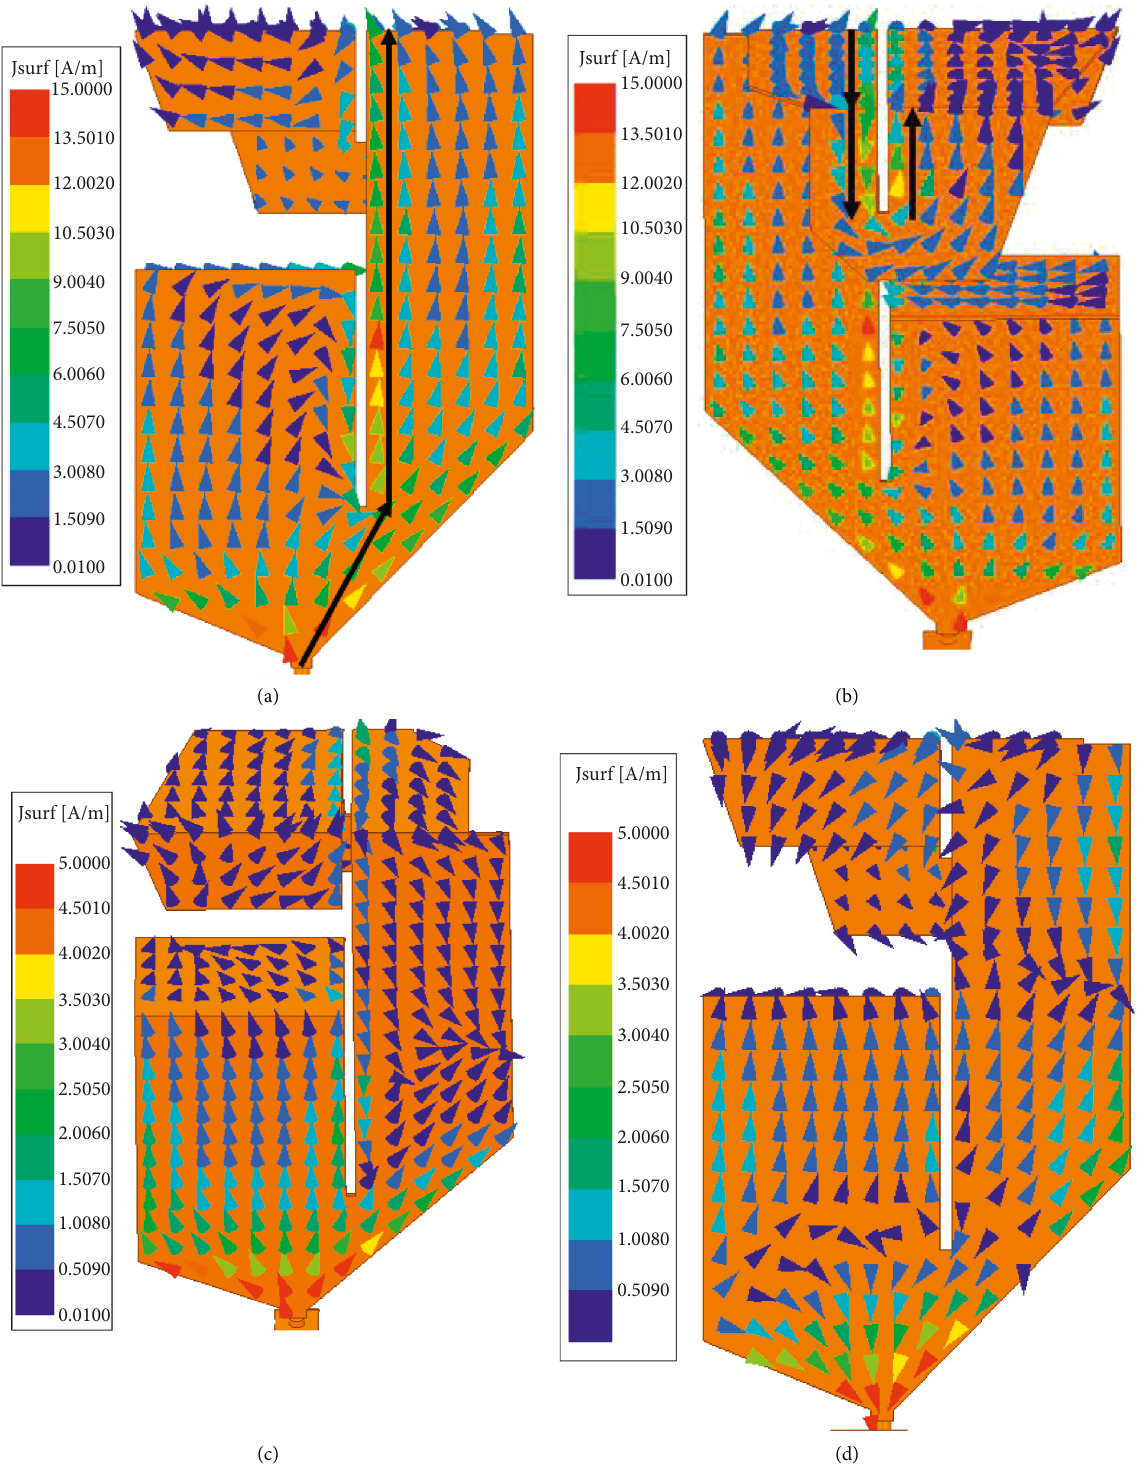
Figure 2: Proposed monopole antenna current distribution. (a) 788MHz (front view). (b) 788MHz (back view). (c) 1559MHz. (d)